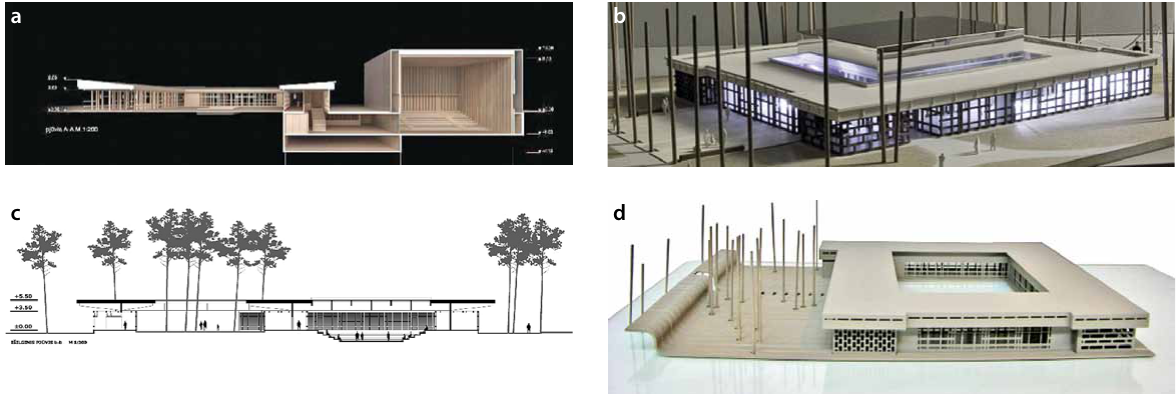
Fig. 8. fragments of the architectural development competition projects for the exhibition pavilion, S. Daukanto/ S. Dariaus